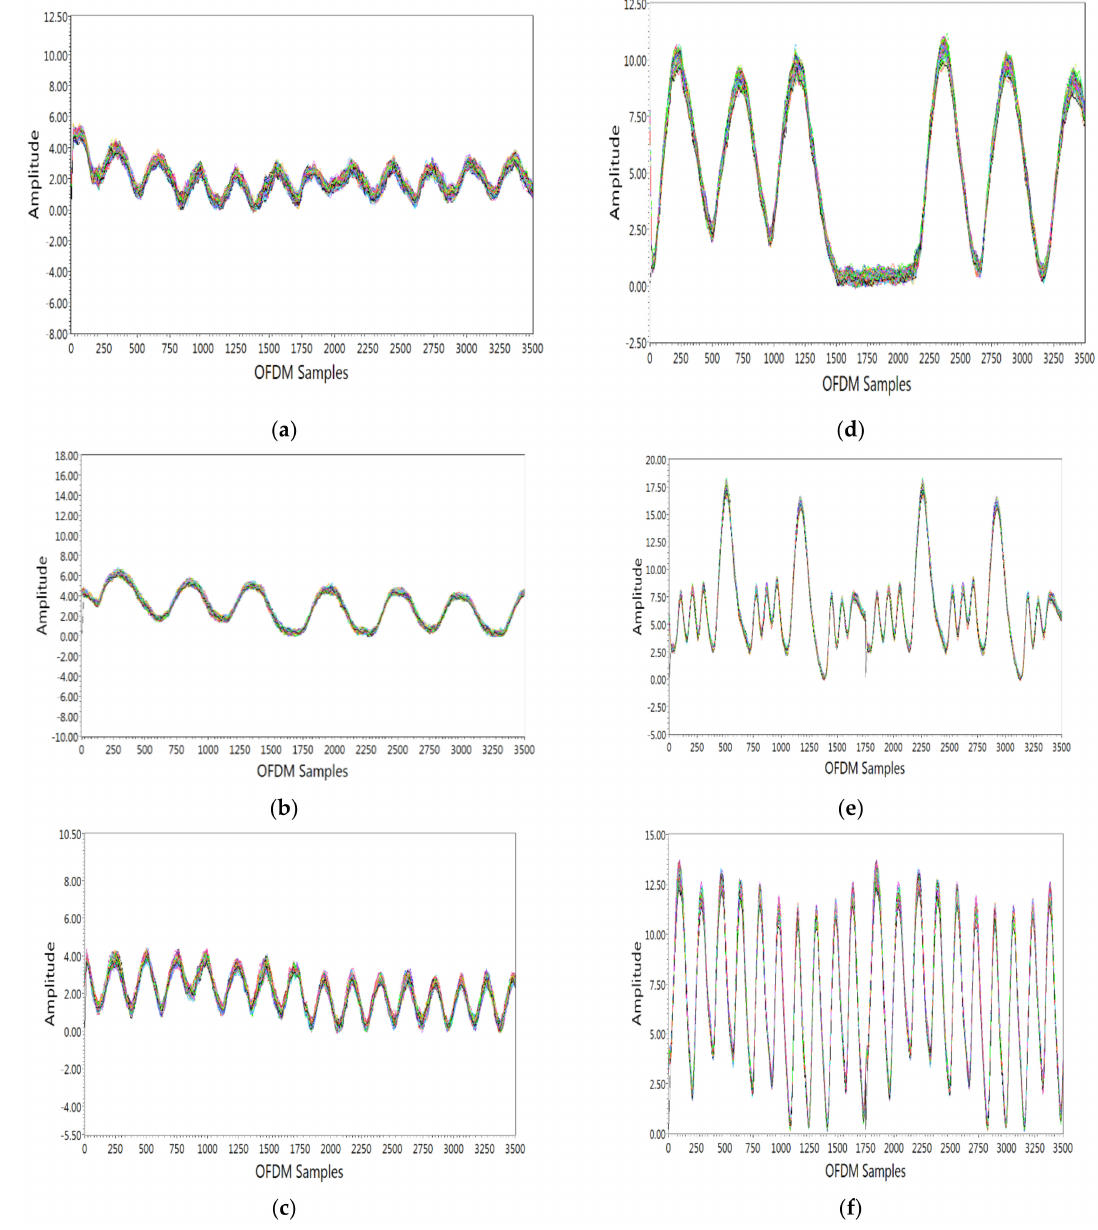
Figure 5. Detection of different abnormal breathing patterns: ( a ) eupnea; ( b ) bradypnea; ( c )tachypnea; ( d ) biot; ( e ) sighing; ( f )